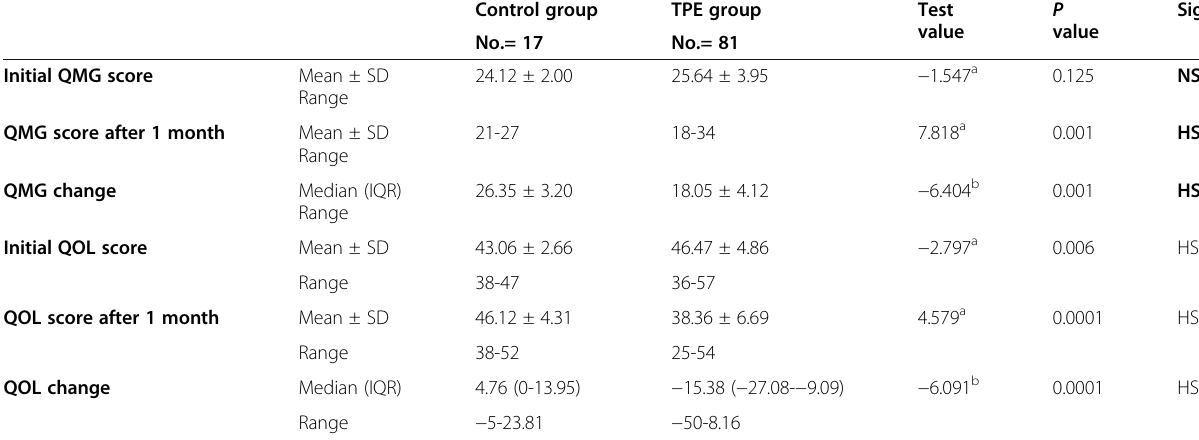
Table 2 Comparison between control group and TPE group regarding QMG and QOL score at initial, after 1 month, and percentage change